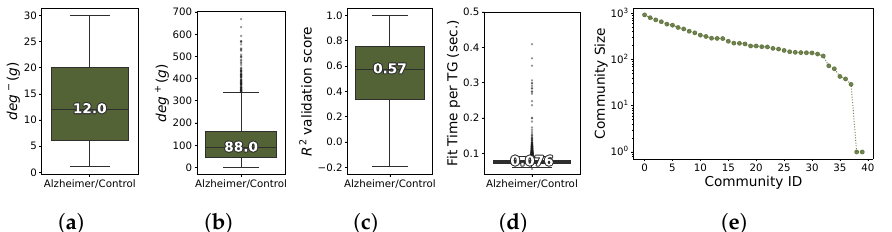
Figure 12. Distribution of TGs in-degree ( a ), TFs out-degree ( b ), R 2 determination coefficients ( c ), run-times ( d ) needed to train each TG model, and number of TGs within each community sorted in decreasing order ( e ), for the H. sapiens Alzheimer/Control dataset; ( a ) TGs in-degree; ( b ) TFs out-degrees; ( c ) R 2 score; ( d ) Run-time; ( e ) Communities